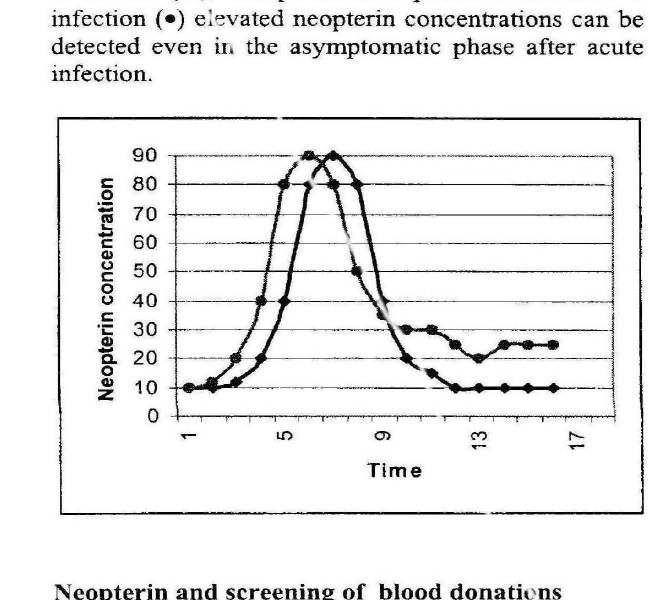
Fig.l: Schematic drawing of neopterin concentrations during acute infections with CMV and HIV -1: after seroconversion neopterin concentrations decline and normalise (.), except in most patients with HIV-l infection (.) elevated neopterin concentrations can be detected even in the asymptomatic phase after acute infection.